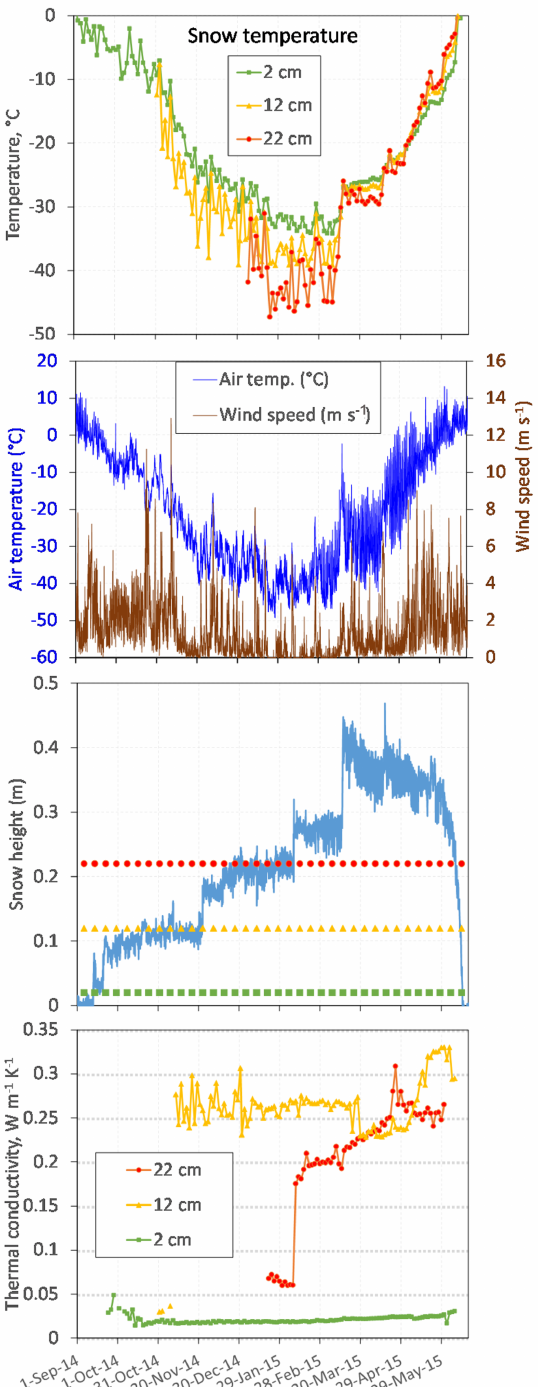
Figure 3. Snow temperature, air temperature, wind speed, snow height and snow thermal conductivity at three heights during the 2014–2015 winter season at Bylot Island. The levels of the three thermal conductivity needle probes (NPs) are indicated in the snow height panel. Note that the snow height gauge and the NPs were about 5m away, so that snow height between both spots may have been different. Snow temperatures were measured with the NPs ev- ery other day at 05:00.